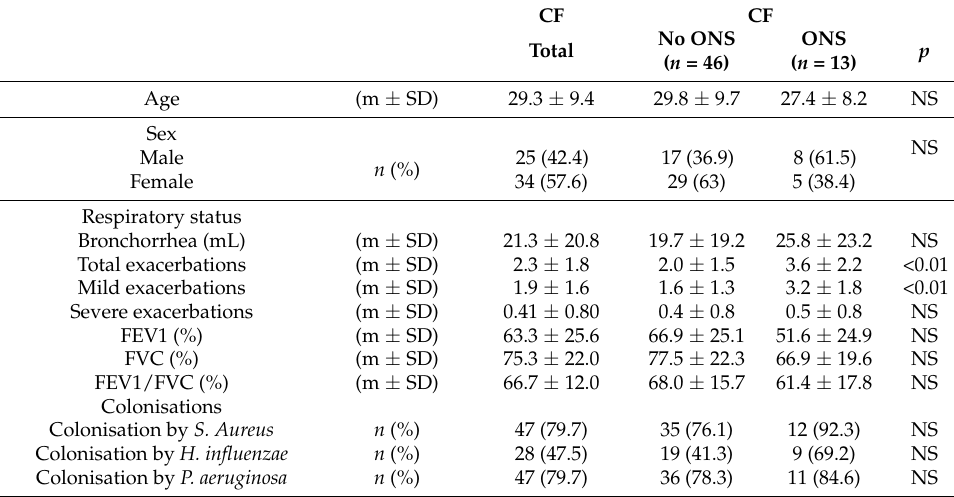
Table 1. General characteristics and respiratory